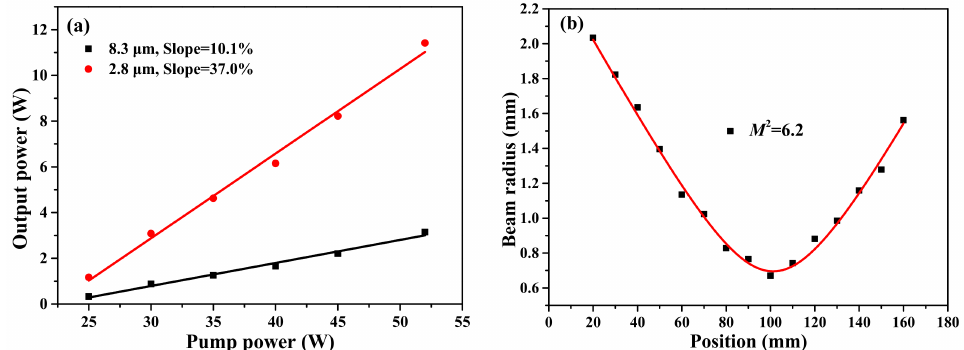
Figure 5. ( a ) Output power, and ( b ) beam quality factor M 2 of ZGP